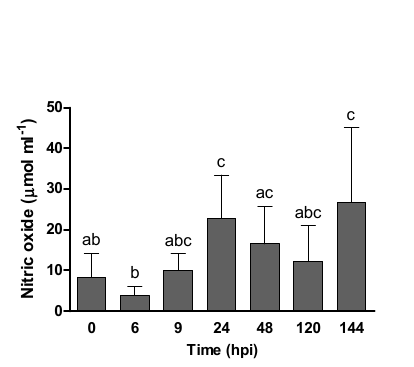
Figure 2. Innate humoral parameters of European seabass ( Dicentrarchus labrax ) infected with RGNNV at different hours post-infection (hpi): ( A ) lysozyme concentration, ( B ) peroxidase activity, ( C ) antiproteases activity, ( D ) proteases activity and ( E ) nitric oxide are presented as mean ± SD ( n = 6). One-way ANOVA was used to compare between different sampling times. Different letters show statistically significant differences between sampling times ( p < 0.05).